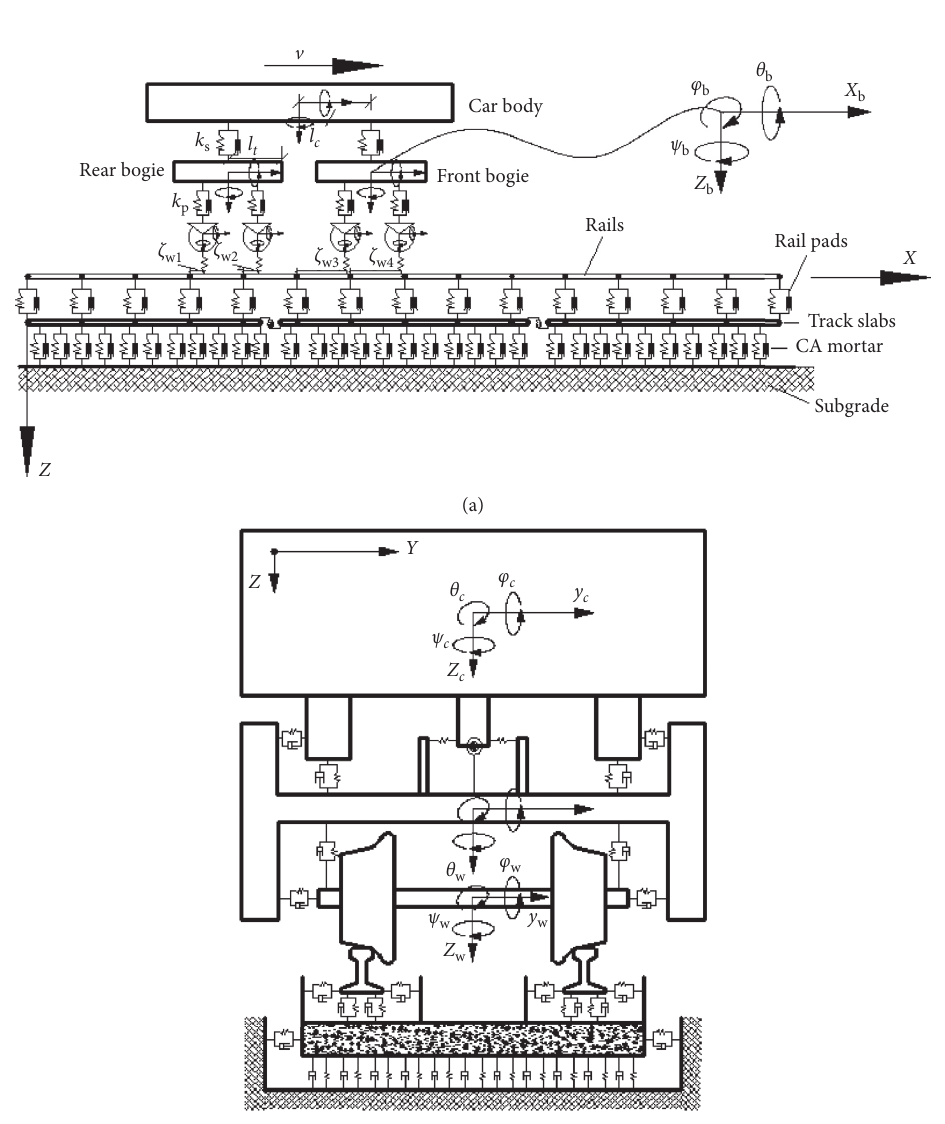
Figure 3: Vehicle-track 3D model. (a) Side view; (b) end view